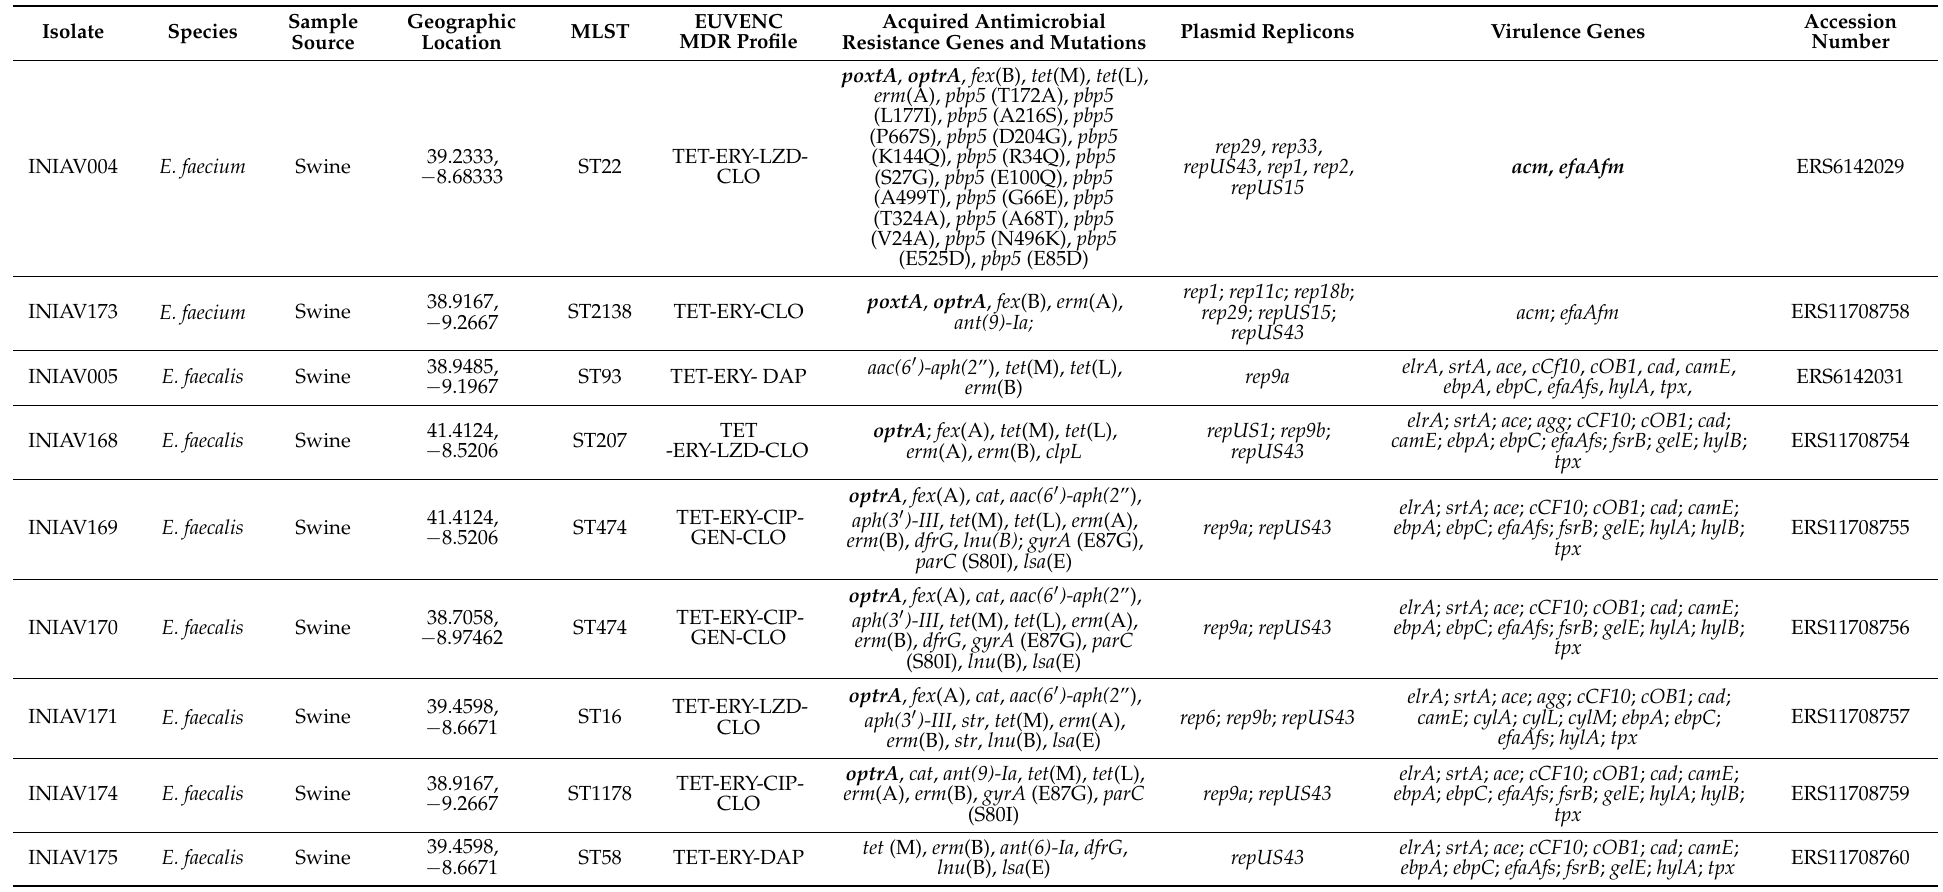
Table A1. Genomic characterization of Enterococcus faecium ( n = 2) and Enterococcus faecalis ( n = 7) strains from pig cecal